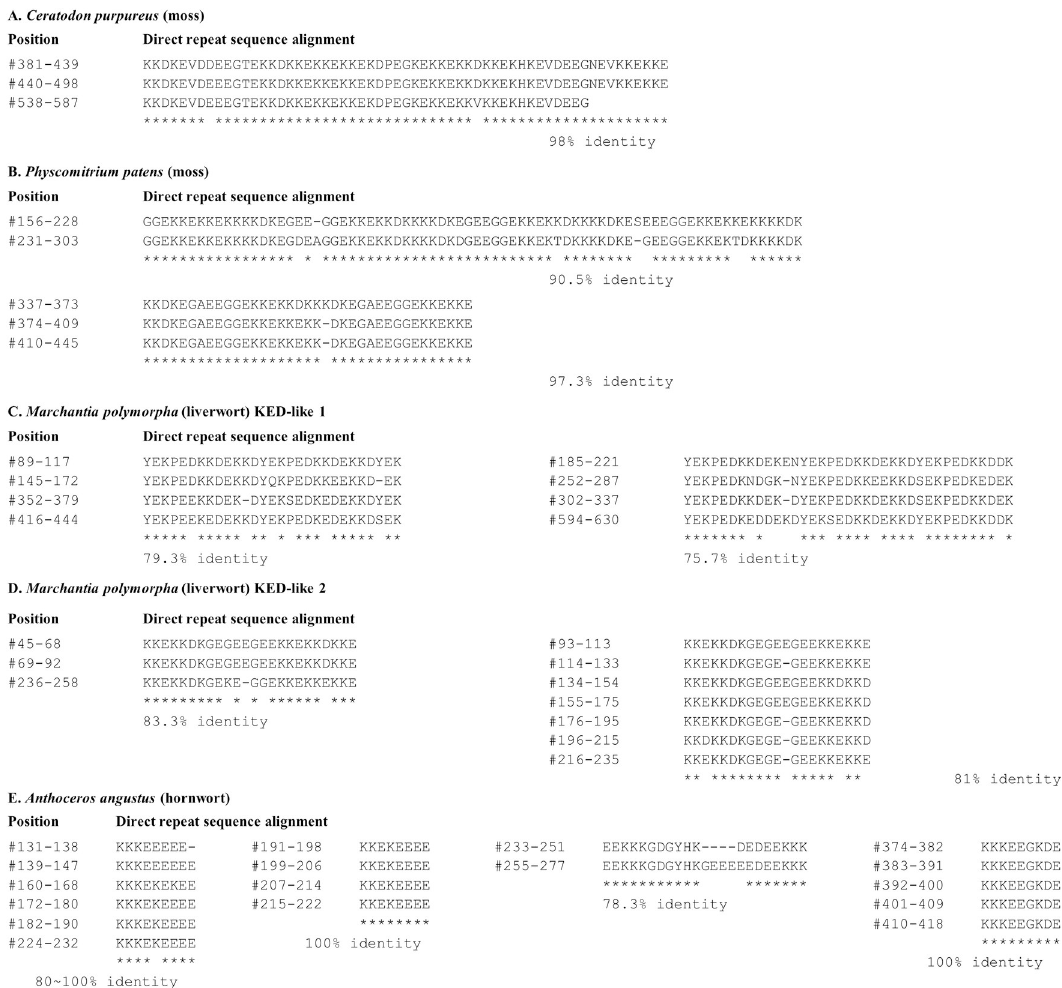
Fig 3. Distribution and identity of direct repeats in bryophyte KED-rich proteins. A and B , two moss species; C and D , two isoforms from a liverwort species; E , a hornwort species. Locations of the repeats within each protein are indicated by residue positions in the sequence. “-” is gap introduced to maximize the alignment. � denotes identical